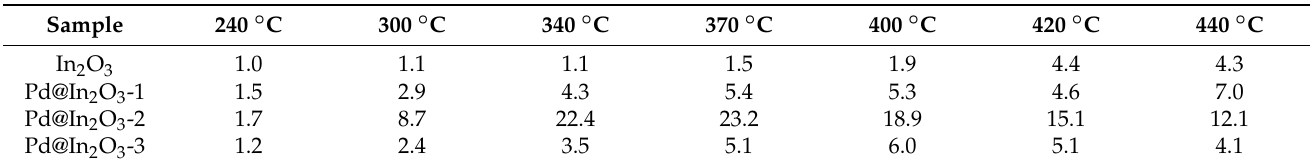
Table 1. Response of pristine In 2 O 3 and Pd@In 2 O 3 -1, Pd@In 2 O 3 -2, and Pd@In 2 O 3 -3 samples at different temperatures.